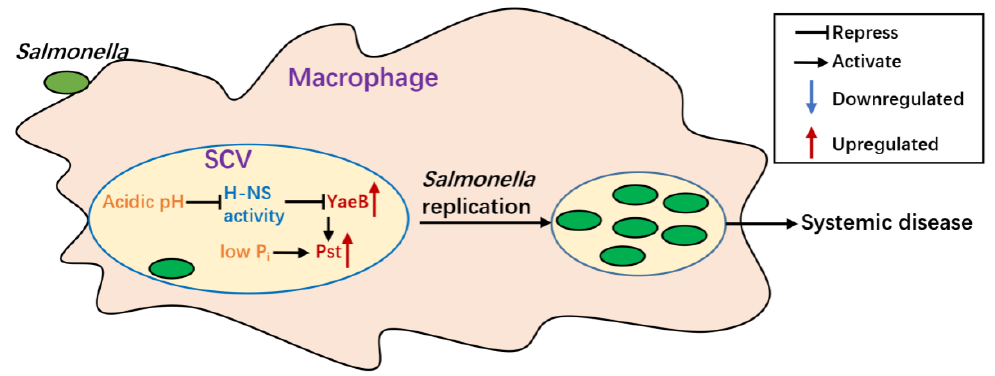
Figure 6. YaeB-mediated virulence model of S . Typhimurium. Once S . Typhimurium entered into macrophages, the acidic pH of SCVs relieved the inhibitory effects of H-NS on yaeB , and activation of YaeB resulted in upregulation of components of the Pst system, which promoted replication of S . Typhimurium within macrophages and accelerated S . Typhimurium spread and systemic infection.